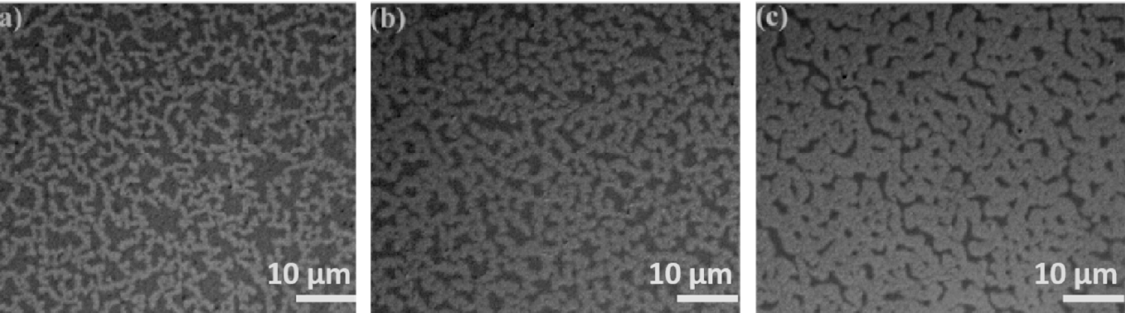
Figure 1. Morphology of Au films deposited on silicone oil surfaces with film thickness of ( a ) 5 nm, ( b ) 10 nm, and ( c ) 20 nm, respectively.